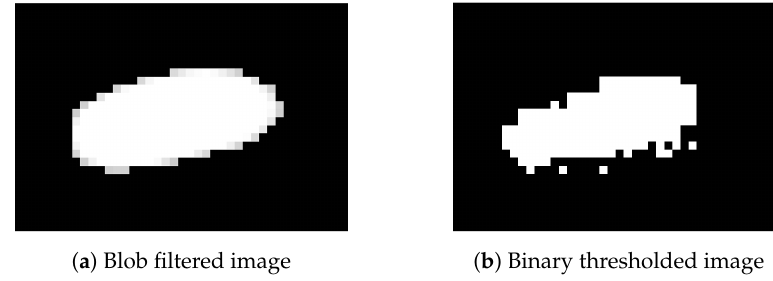
Figure 11. ( a ) Blob filtering and ( b ) normal binary thresholding. A comparison between applying the blob filter and applying normal binarization to a fly in the extracted flies image. The result of the blob filter provides a clear oval shape of a single fly while the result of the normal binarization contains some noises.